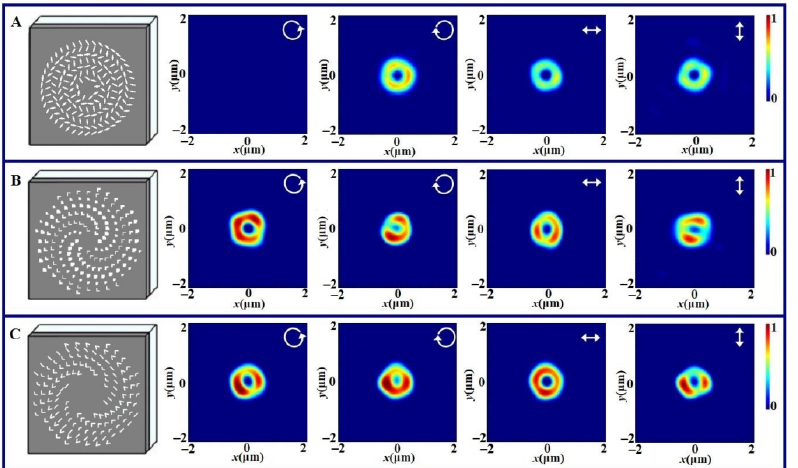
Figure 3. Schematic diagrams of three vortex metalenses with the topological charge of vortex taking 1 and their focusing intensity distributions with RCP, LCP, HLP and VLP light illumination, where ( A ) is for the geometric phase vortex metalens, ( B ) is for the propagation phase vortex metalens and ( C ) is for the resonant phase vortex metalens. The inserted arrows in the intensity distributions denote the incident polarization